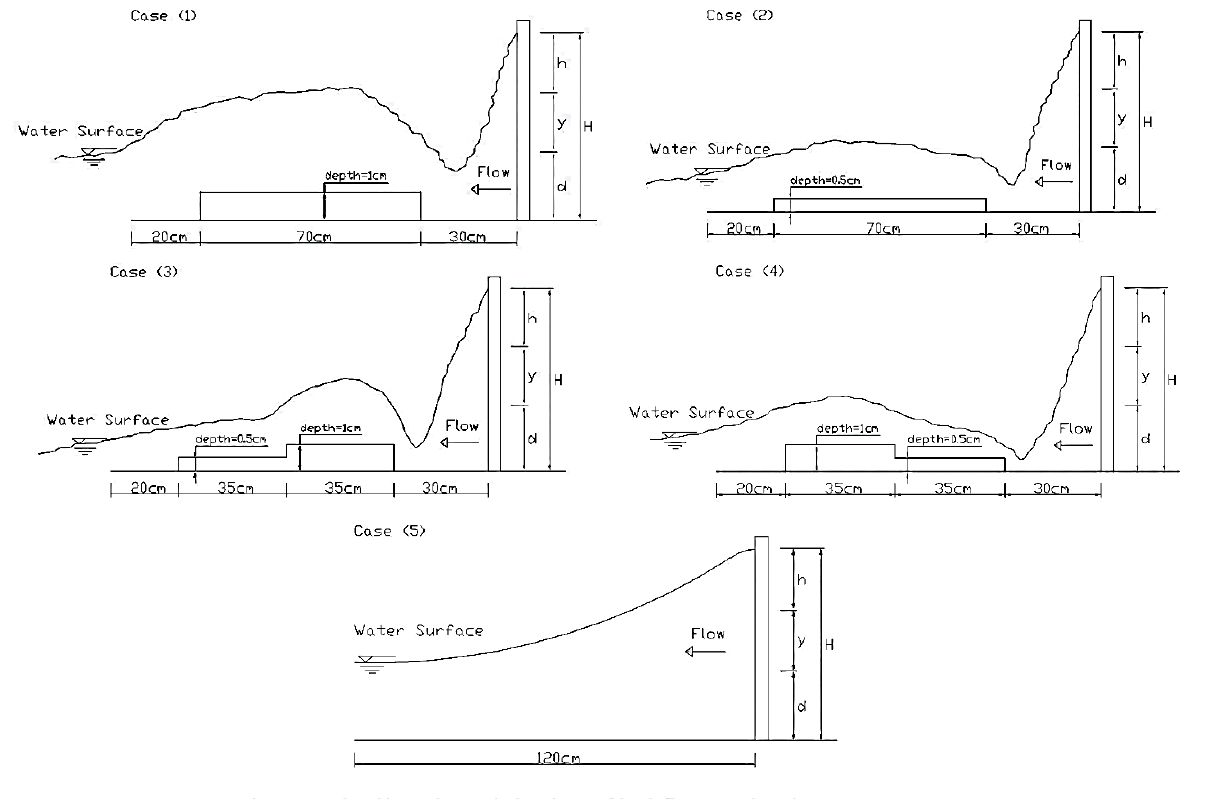
Figure 2. The discordance in horizontal bed flume and weir-gate structure